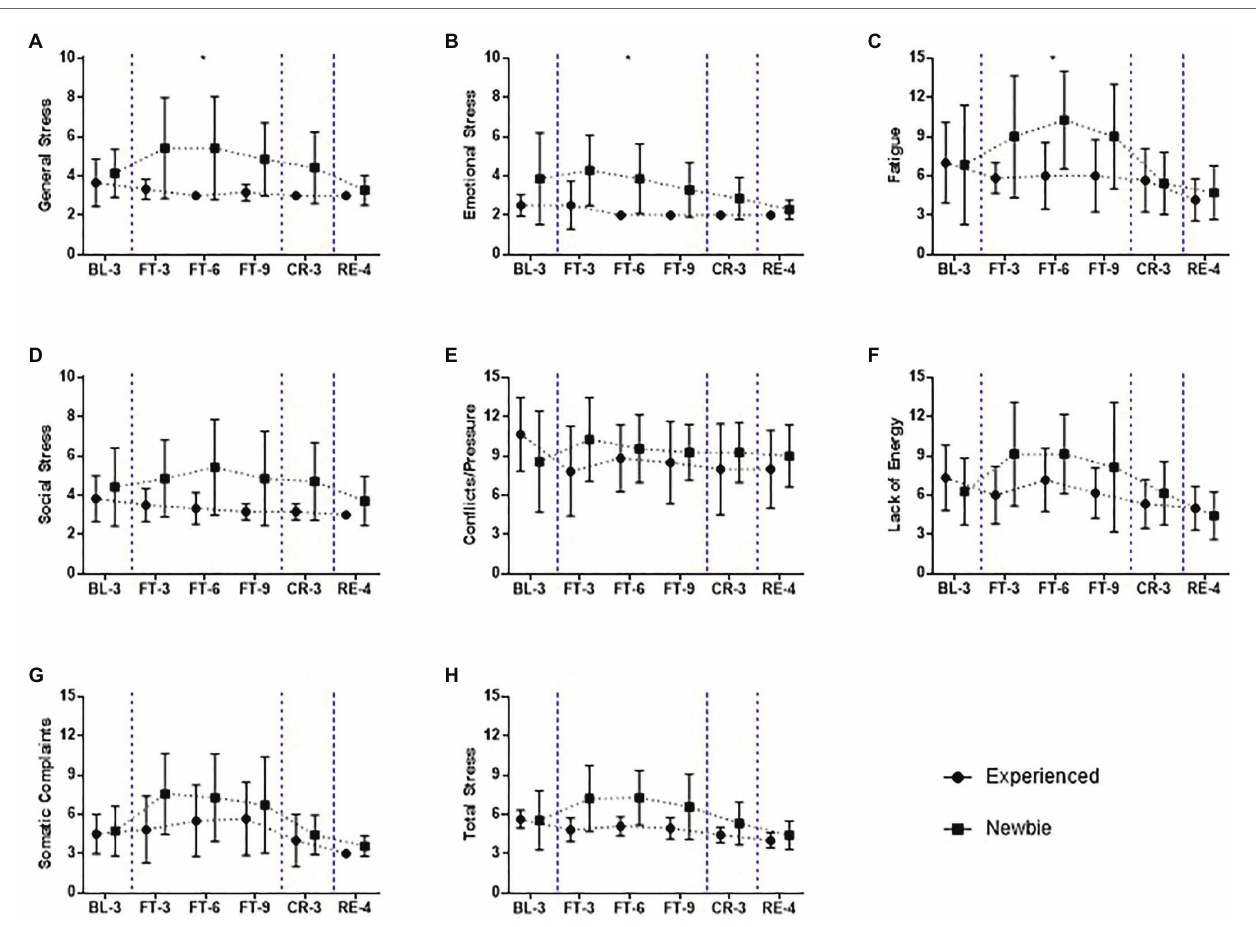
FIGURE 6 | Mean and SD of subscales of stress scores over the 22-day experiment for the Experienced and Newbie groups. (A-H) The scores of the subscales related to the stress in the recovery-stress questionnaires (RESTQ). Symbols represent mean scores for the two groups, and error bars represent the SD of the mean. * p < 0.05 indicates significant differences between the two groups at a given test point. Blue dashed lines indicate the different